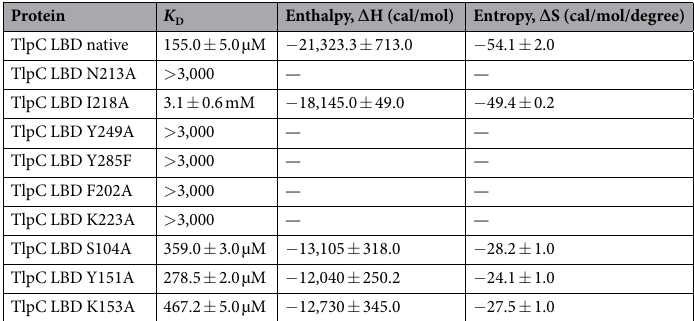
Table 1. Thermodynamic parameters of lactate binding to TlpC LBD and its variants derived from ITC measurements.